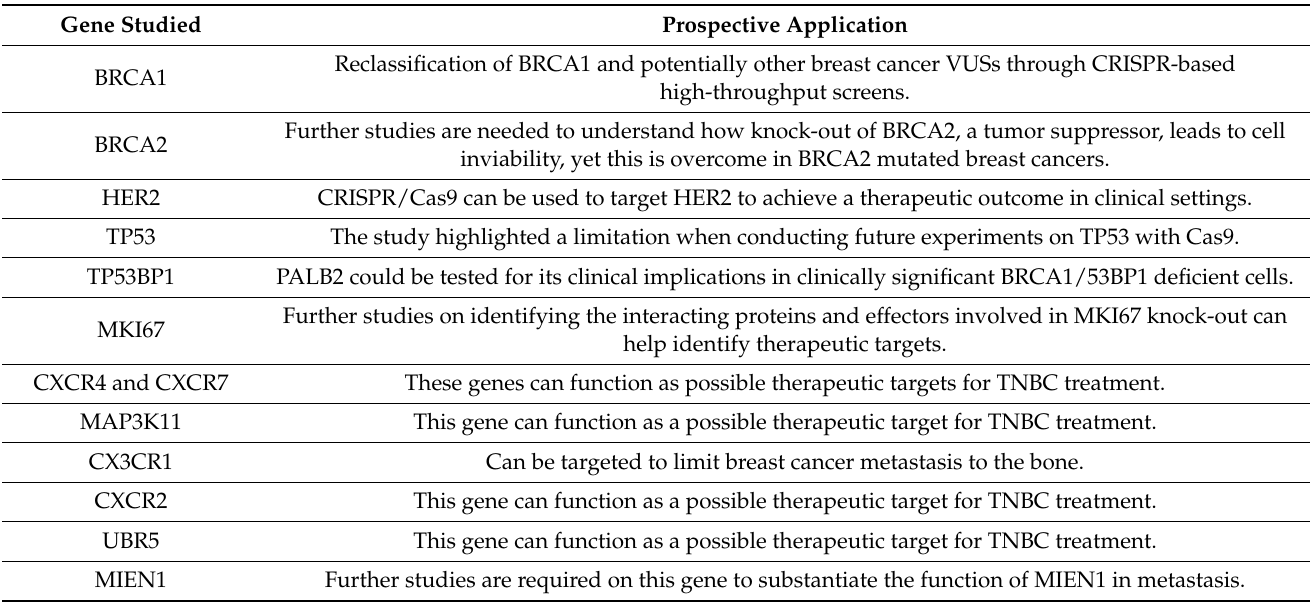
Table 6. Future implications of breast cancer genes studied using